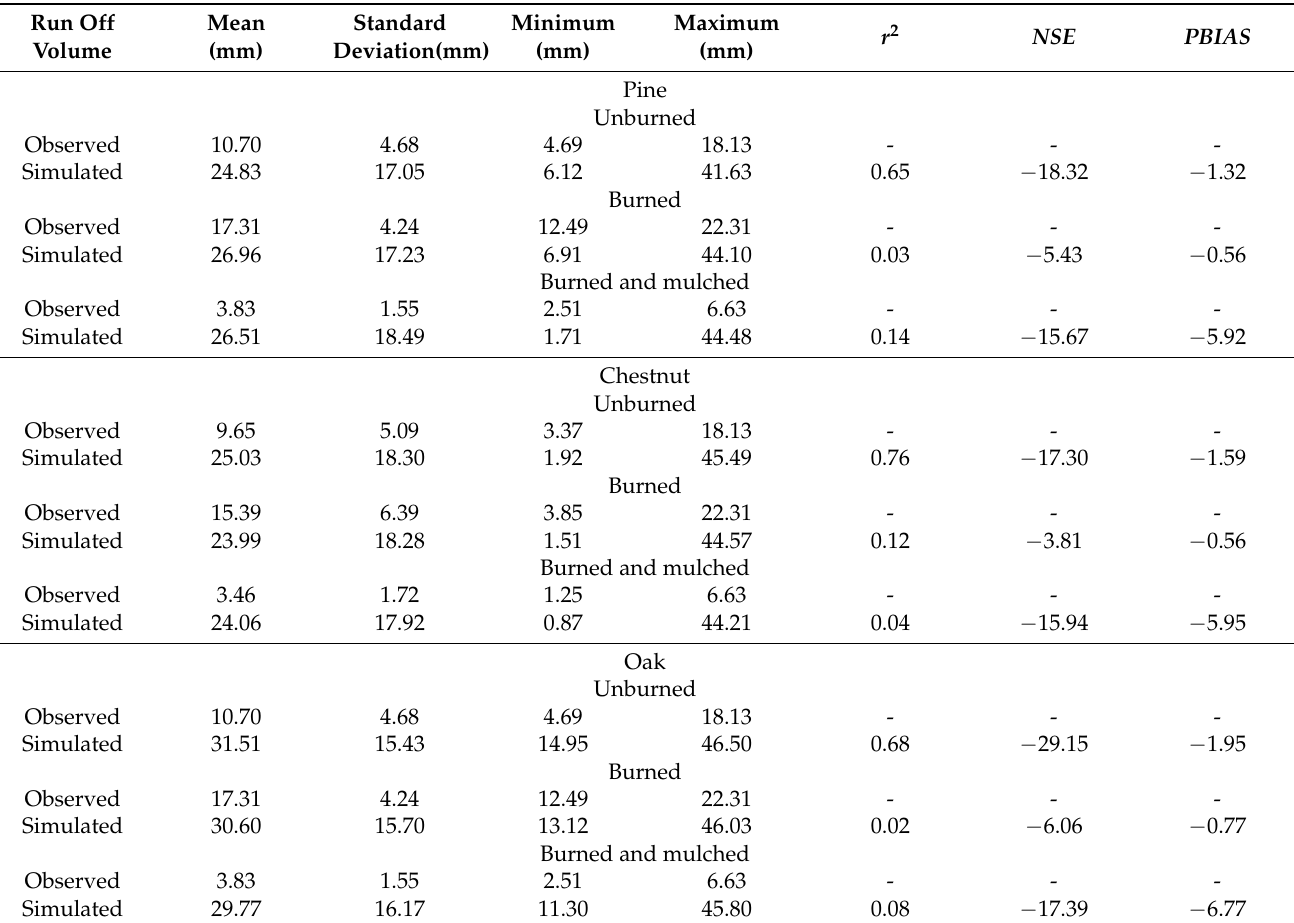
Table 4. Statistics and indexes evaluating the runoff prediction capability of the Horton model in forest plots subject to prescribed fire and soil mulching with